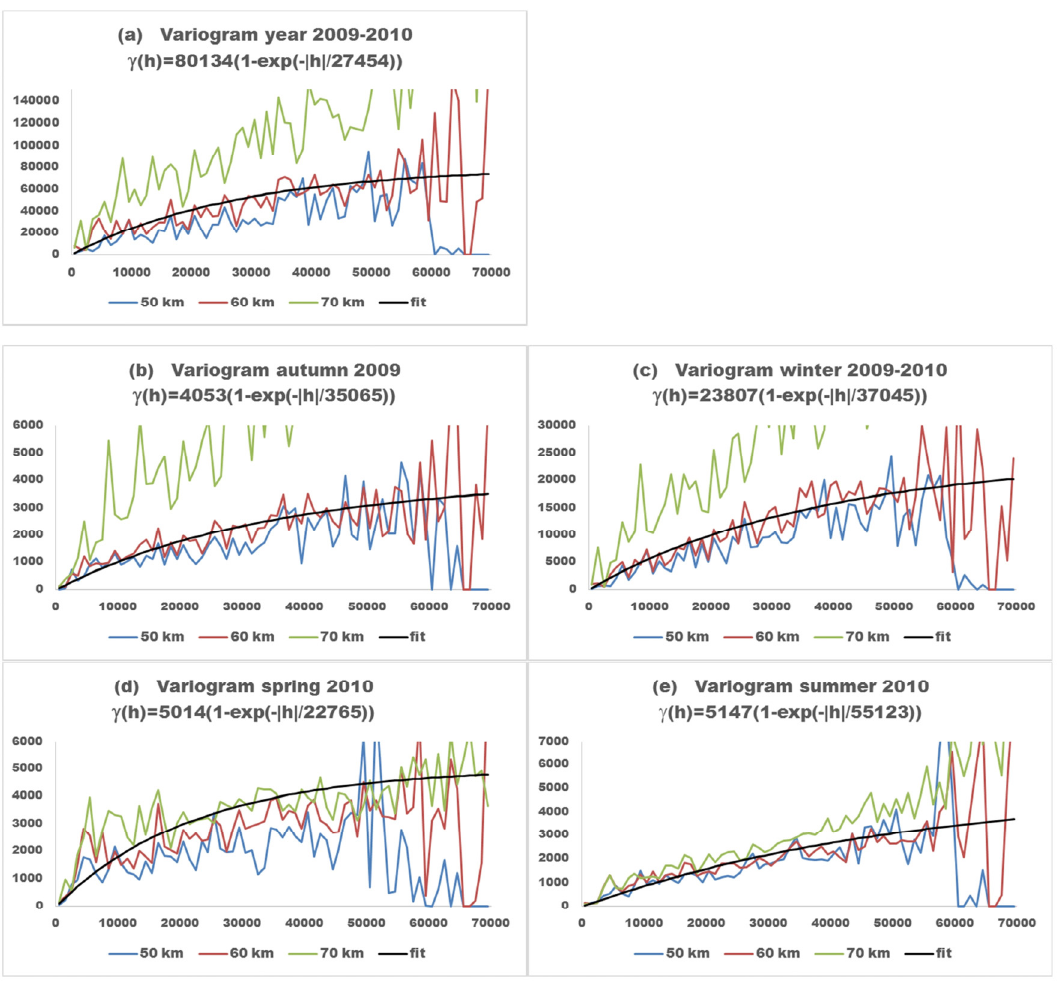
Figure 3. Variograms of annual ( a ) and seasonal ( b , c , d , e ) ACR (year: 2009–2010, areas centered at lat. 43.75 ◦ , lon. 11.25 ◦ ). The sample values obtained with the measurements inside 50 × 50, 60 × 60, and 70 × 70 km 2 areas are reported. The distances of the points (meters) are reported in the abscissa, the values of the variogram (mm 2 ) in the ordinate. The fitting function is also reported.